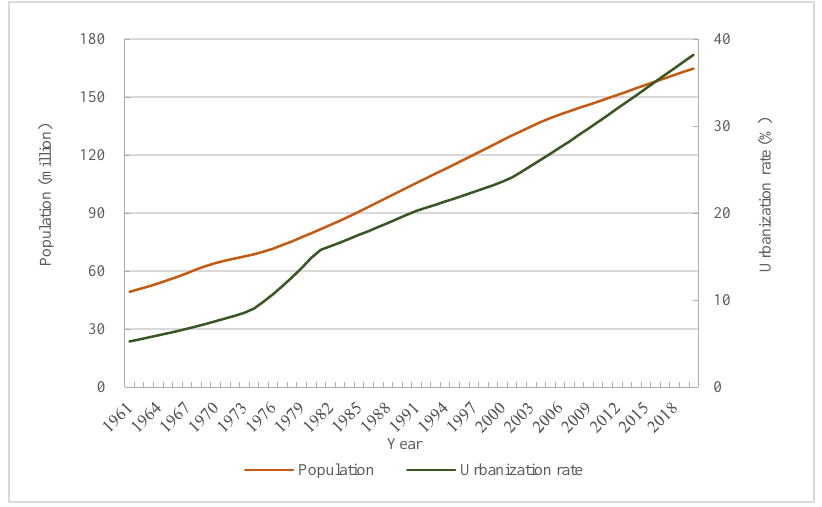
Figure 4. Change of population and urbanization rate.